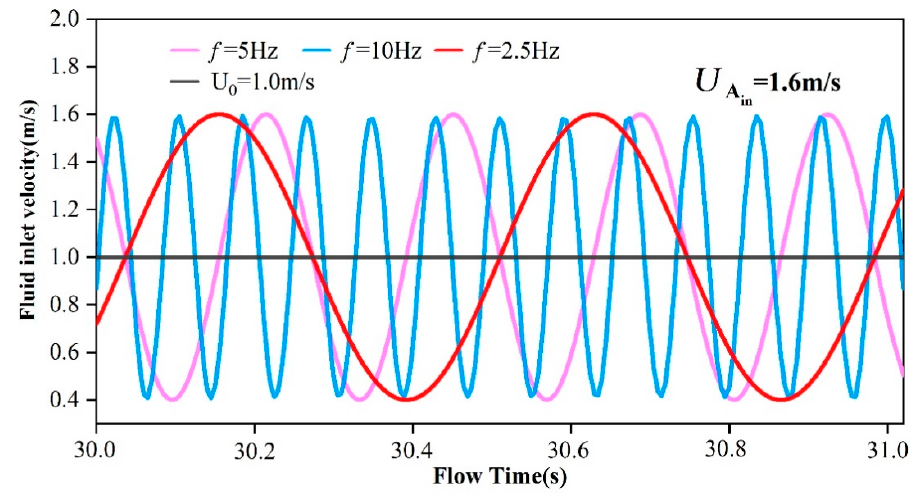
Figure 4. Graph of the pulse waveform with different frequencies. In the pulsed gravel packing process of horizontal wells, three layers of hydraulic flow may occur in annular flow field, which are fixed bed, moving bed, and suspended bed as shown in Figure 5 .